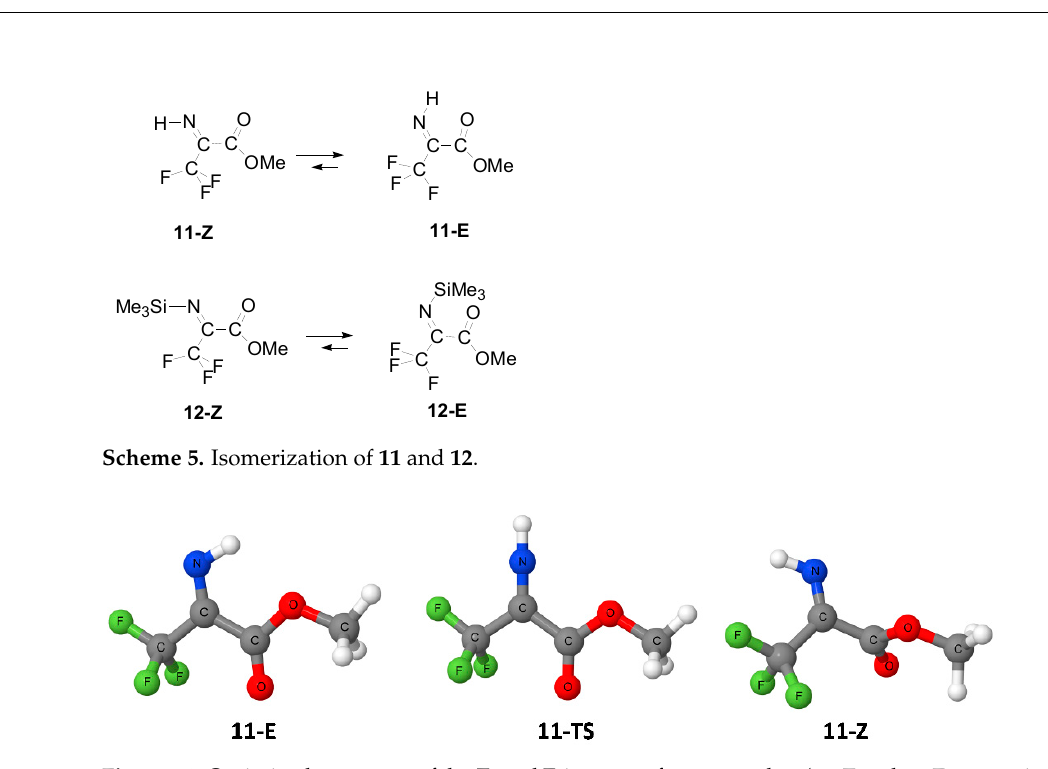
Figure 14. Optimized structures of the Z- and E-isomers of compound 11 ( 11-Z and 11-E , respec-